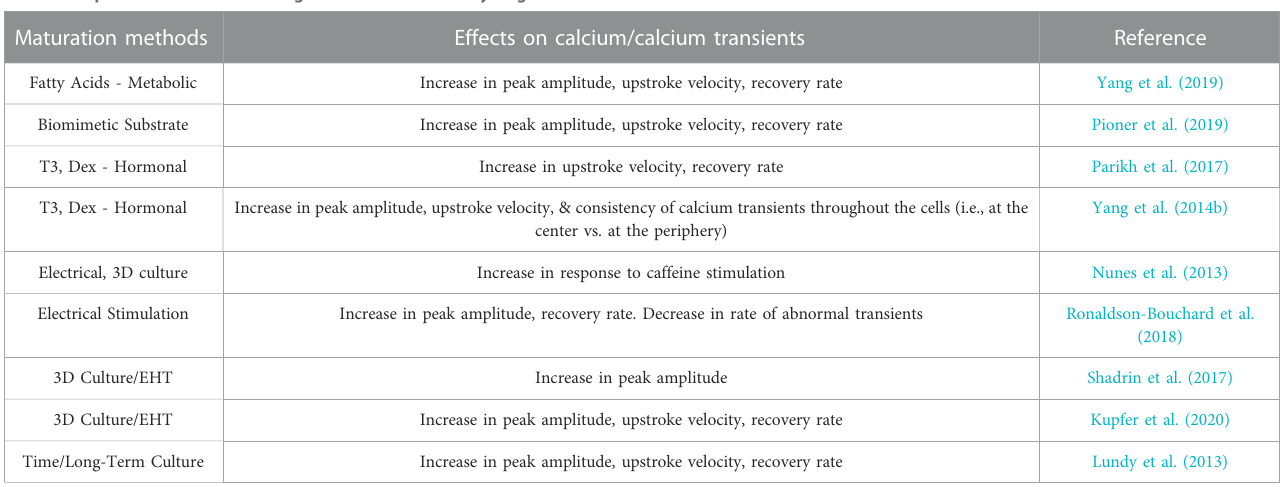
TABLE 1 Impact of maturation strategies on hiPSC calcium